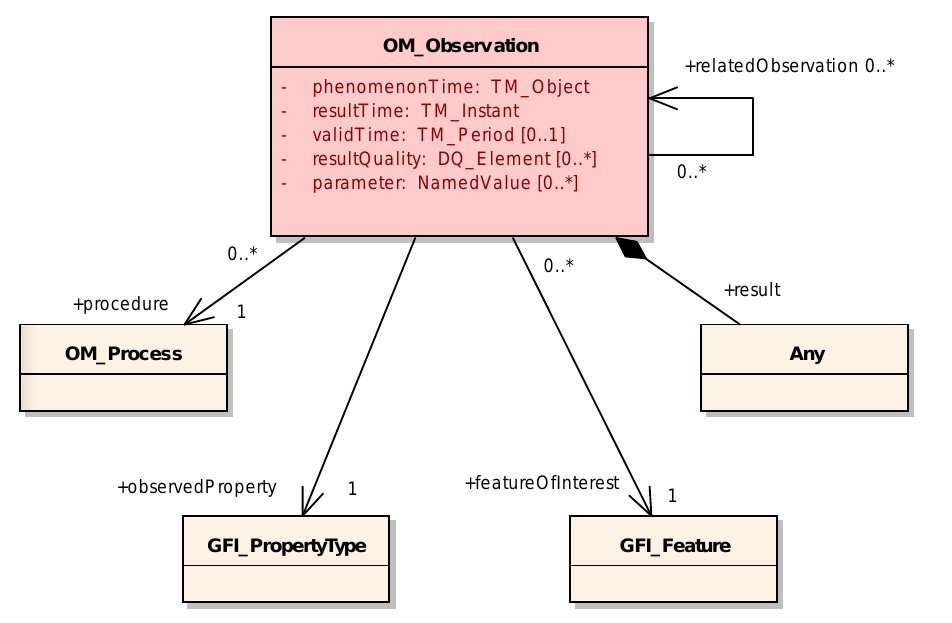
Figure 3. Basic observation model of O&M